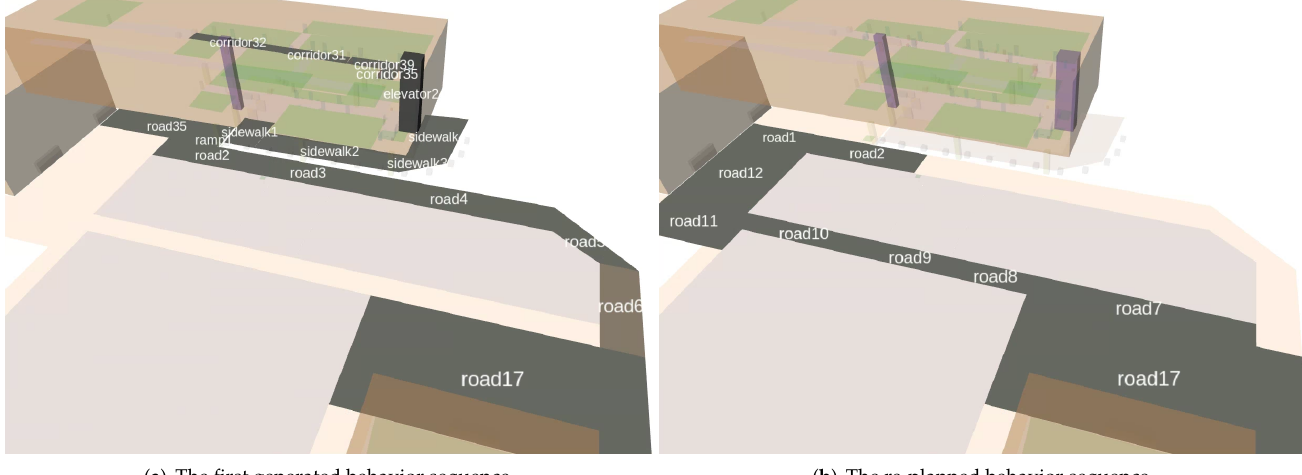
Figure 8. The behavior sequence generated by the task planner. ( a ) The plan result from corridor32 to road17. ( b ) The re-plan result from road2 to